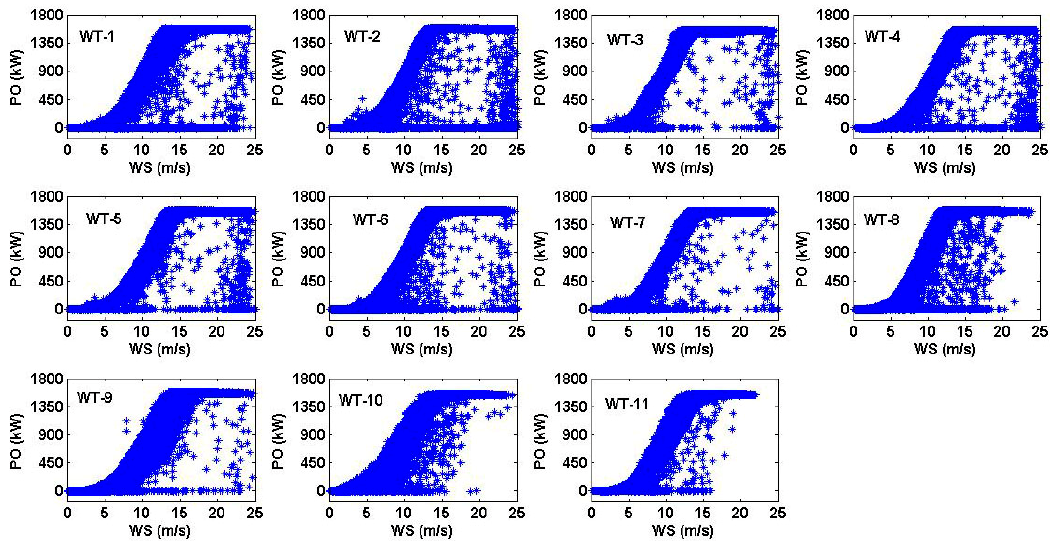
Figure 3. Scatter plot of the wind speed vs the power output of the 11 WTs of the VWF for 2014. WTi: i -th wind turbine, i P t 1, . . . ,11 u ; PO: Power output; WS: Wind speed.